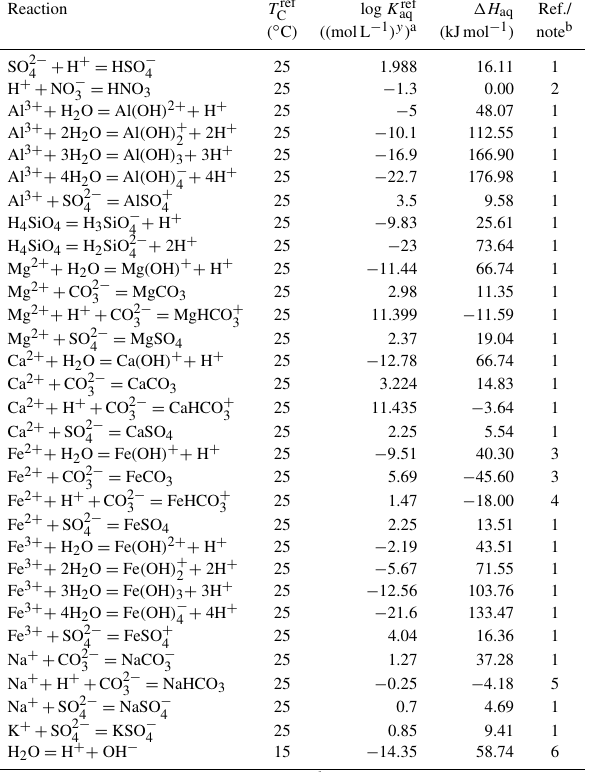
Table 3. Thermodynamic data for aqueous species a . Reaction T ref C log K ref